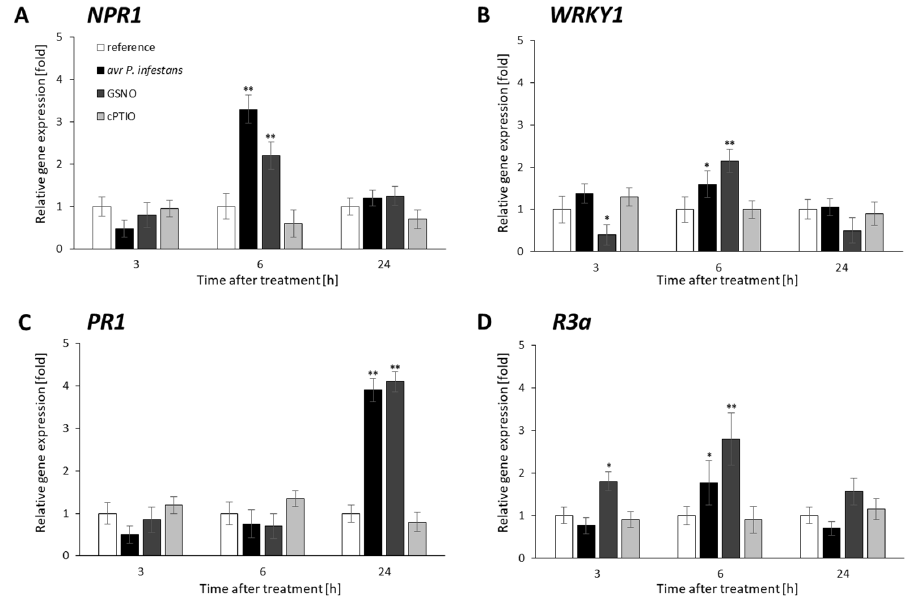
Figure 2. Effects of avr P. infestans and GSNO on potato defense genes transcription. RT-qPCR analysis of the NPR1 ( A ), WRKY1 ( B ), PR1 ( C ), and R3a gene expression ( D ) was performed at selected time points at 3–24 h after GSNO, cPTIO treatment, or challenge inoculation, respectively. Values represent the means of data ± SD of at least three independent experiments. Asterisks indicate values that differ significantly from water ‐ treated (reference) potato leaves at α < 0.05 ( * ) and α < 0.01 ( ** ).